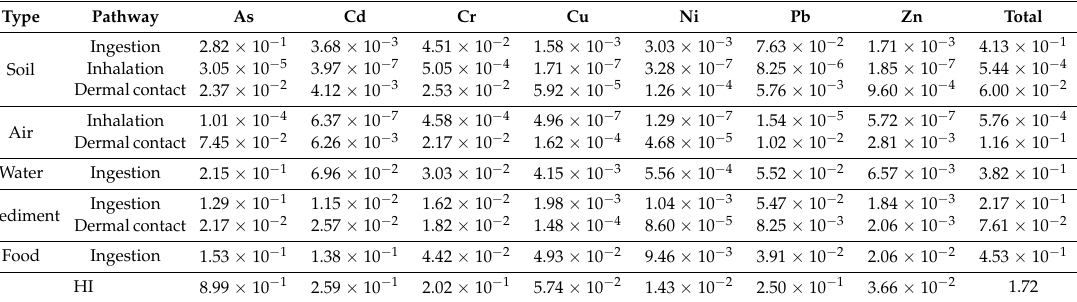
Table 6. Non-carcinogenic risk of trace metals for adults.